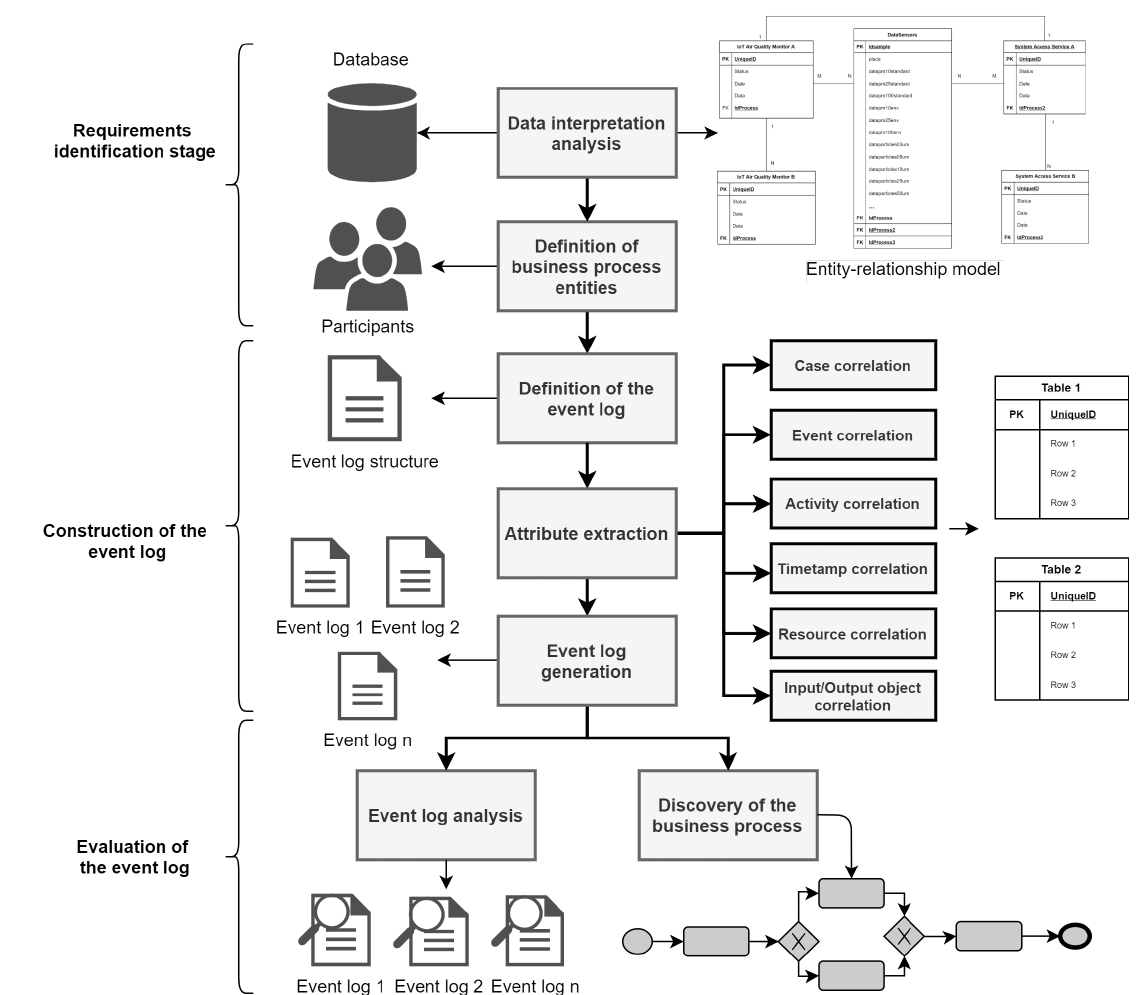
Figure 1. Sequence of activities that make up the framework to generate event